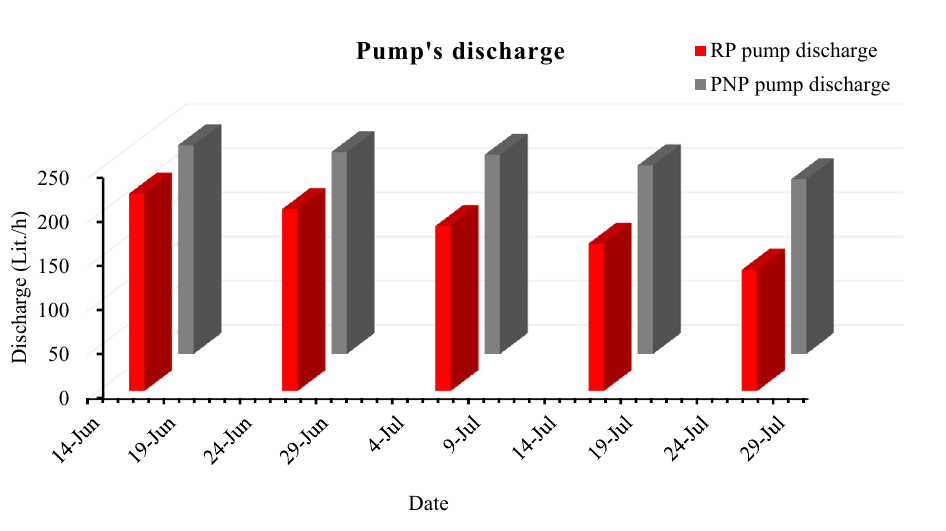
Figure 14. The degradation of RP and PNP pumps’ discharge within 40